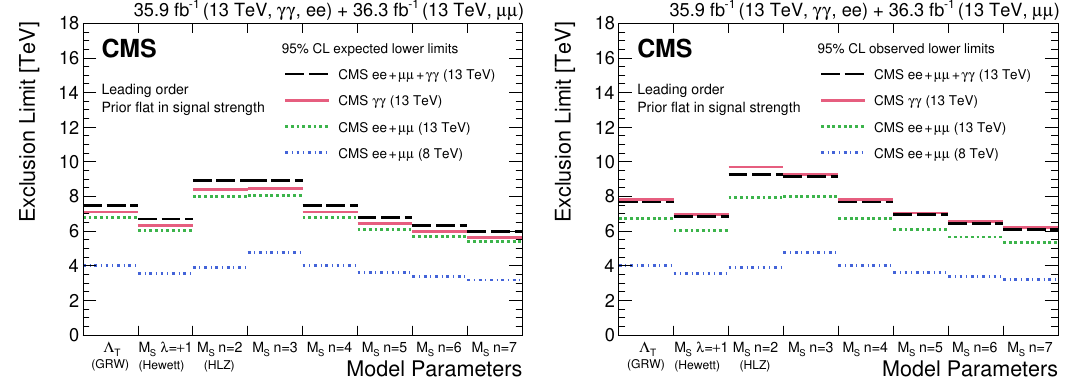
Figure 6 . Individual and combined dilepton (this analysis) and diphoton [10] 95% CL expected (left) and observed (right) exclusion limits as a summary of all parameter conventions for the ADD model. Signal model cross sections are calculated up to leading order. The dilepton limits from the p s = 8 TeV measurement [8] are also shown.